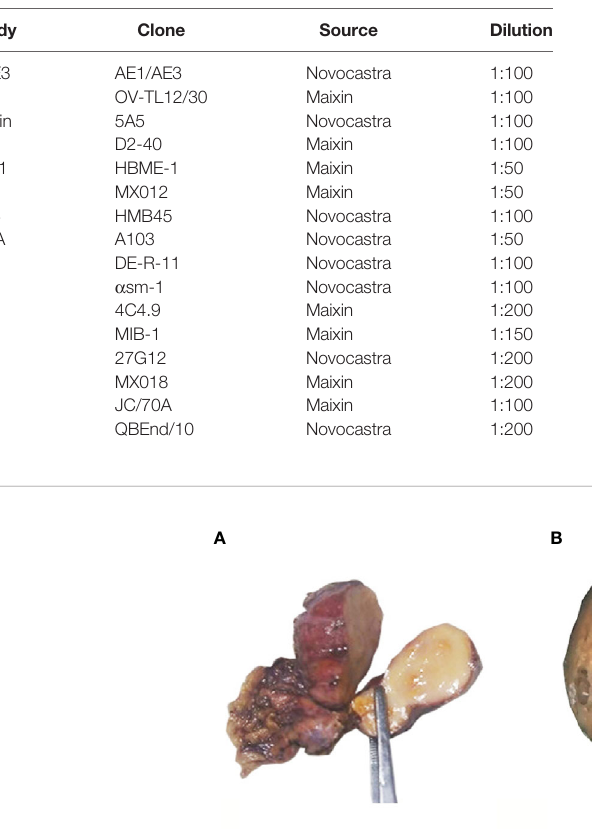
TABLE 1 | Summary of primary antibodies.